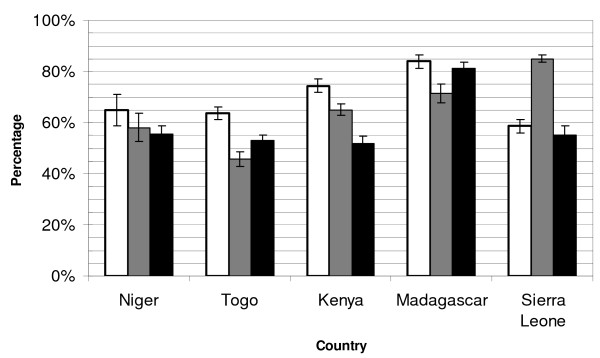
Indicators of ITN ownership and use: survey results following integrated campaigns targeting children <5 years of age in Niger, Togo, Kenya, Madagascar, and Sierra Leone. Bars represent: white: percentage of households that own an ITN (denominator: all households); dark: percentage of ITNs hanging (denominator: all ITNs); and black: percentage of all children less than 5 years of age sleeping under an ITN (denominator: all children less than 5 years of age). Note: household ownership and ITN use by children less than 5 years of age are standard RBM outcome indicators.